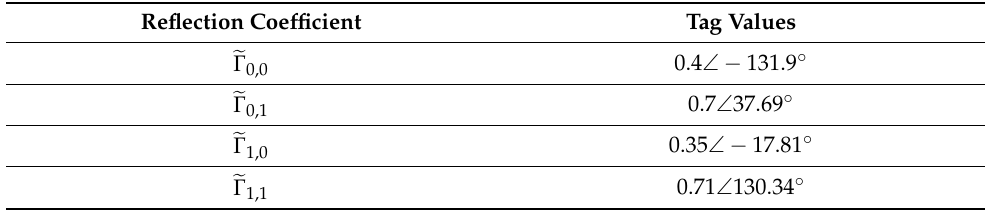
Table 2. Tag reflection coefficients at 925